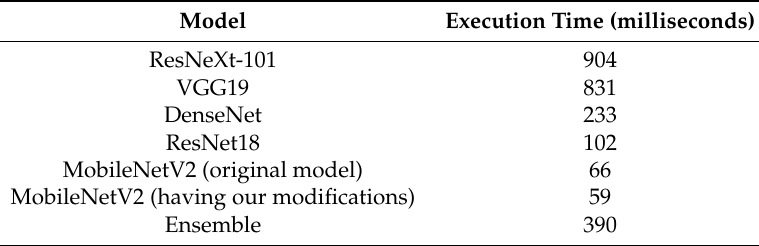
Table 7. Execution times for the networks’ forward